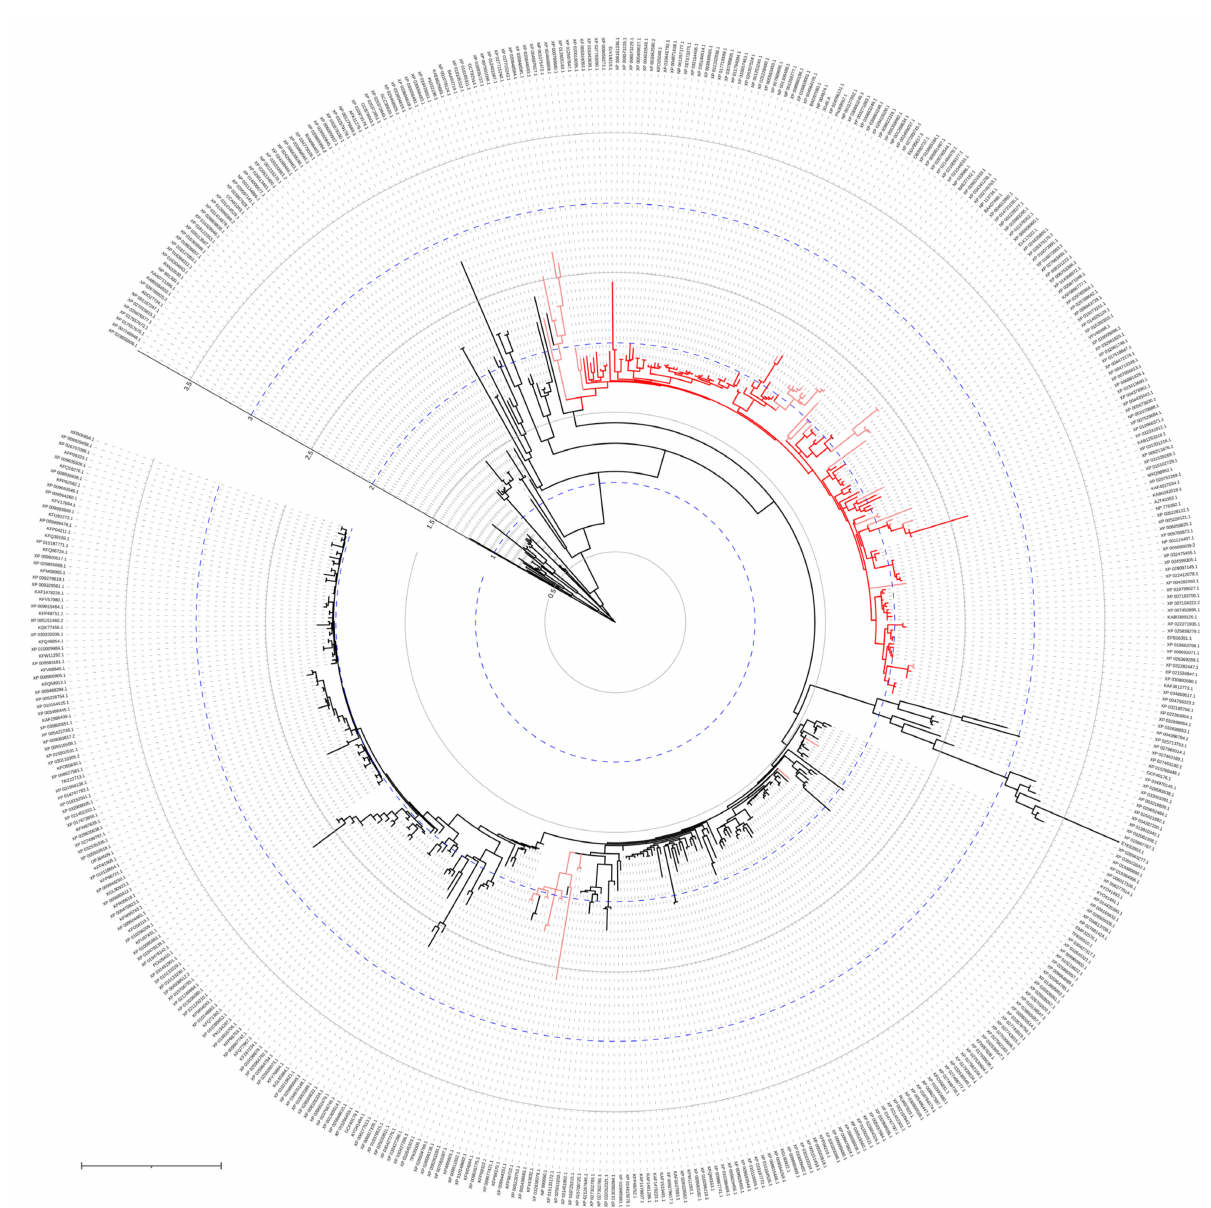
Figure 11. Phylogenetic tree of SMP30 and its homologous enzymes (down to 57% identity). The tree was built as previously with PDB 3G4E as a reference sequence. Enzymes having high (90–100%) and good (80–89%) identity are highlighted with red and pink,